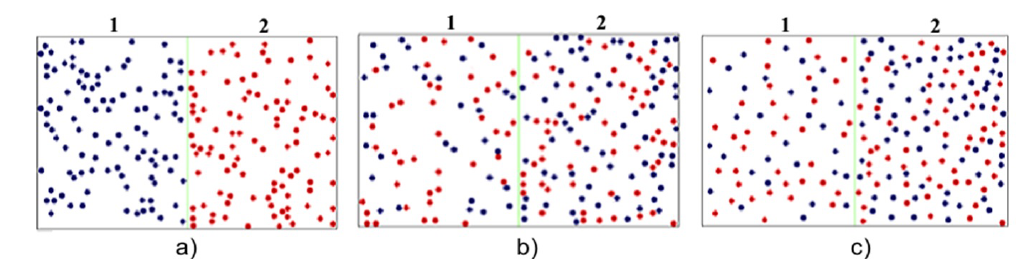
Figure 4. Result of the simulation of di ff usion in single component at the simulated time of t: a) t = 0, b) t = 10 minutes and c) t = 20